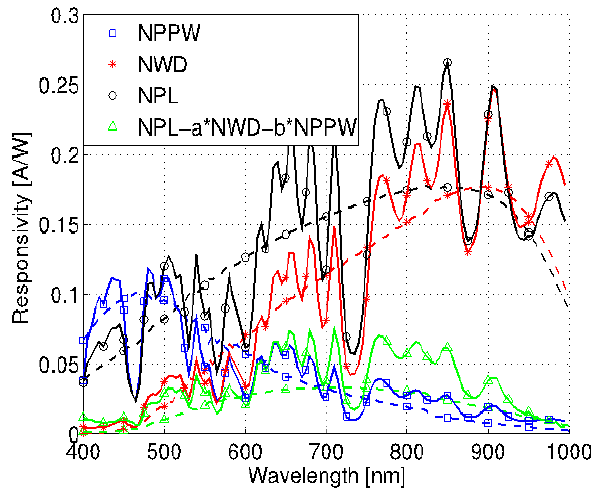
Figure 16. Measured responsivity of the three color sensor signals in comparison to